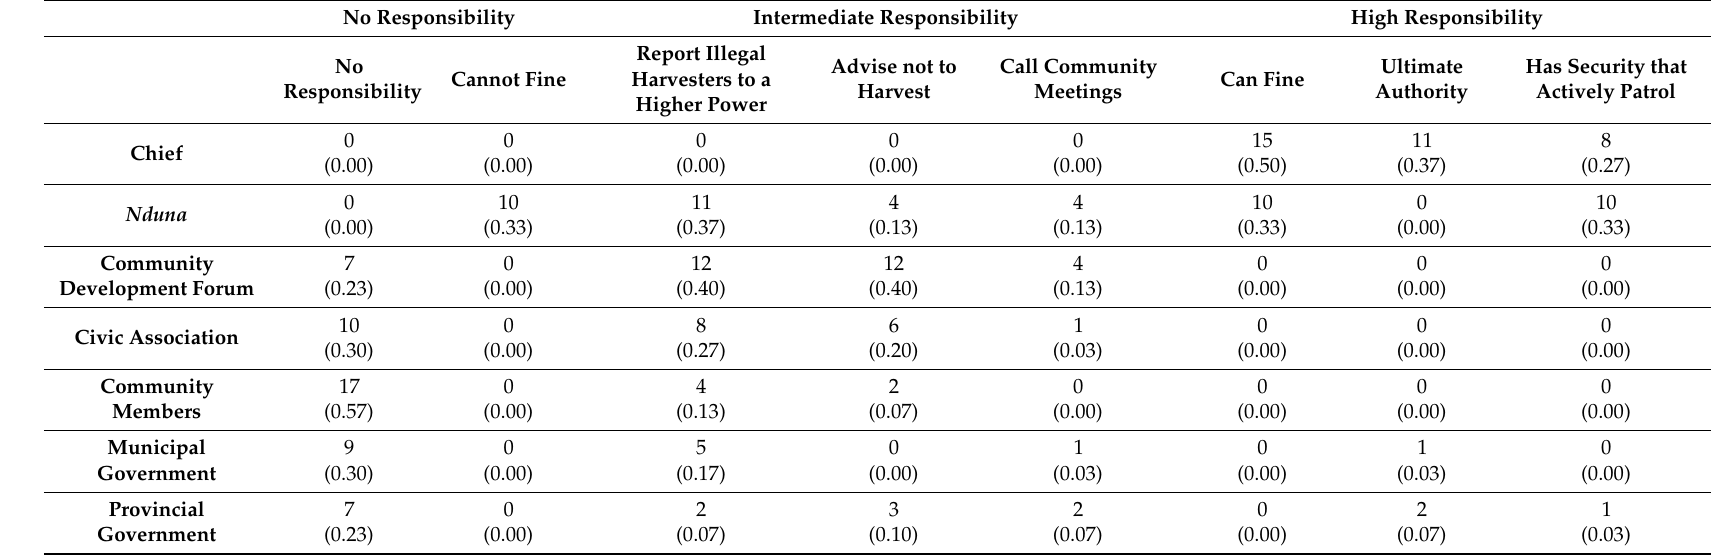
Table 3. The frequency of selected duties thought to be undertaken by different institutions as cited by leaders ( n = 30) pooled across villages. Values in parentheses indicate the proportion of groups in which the duty was